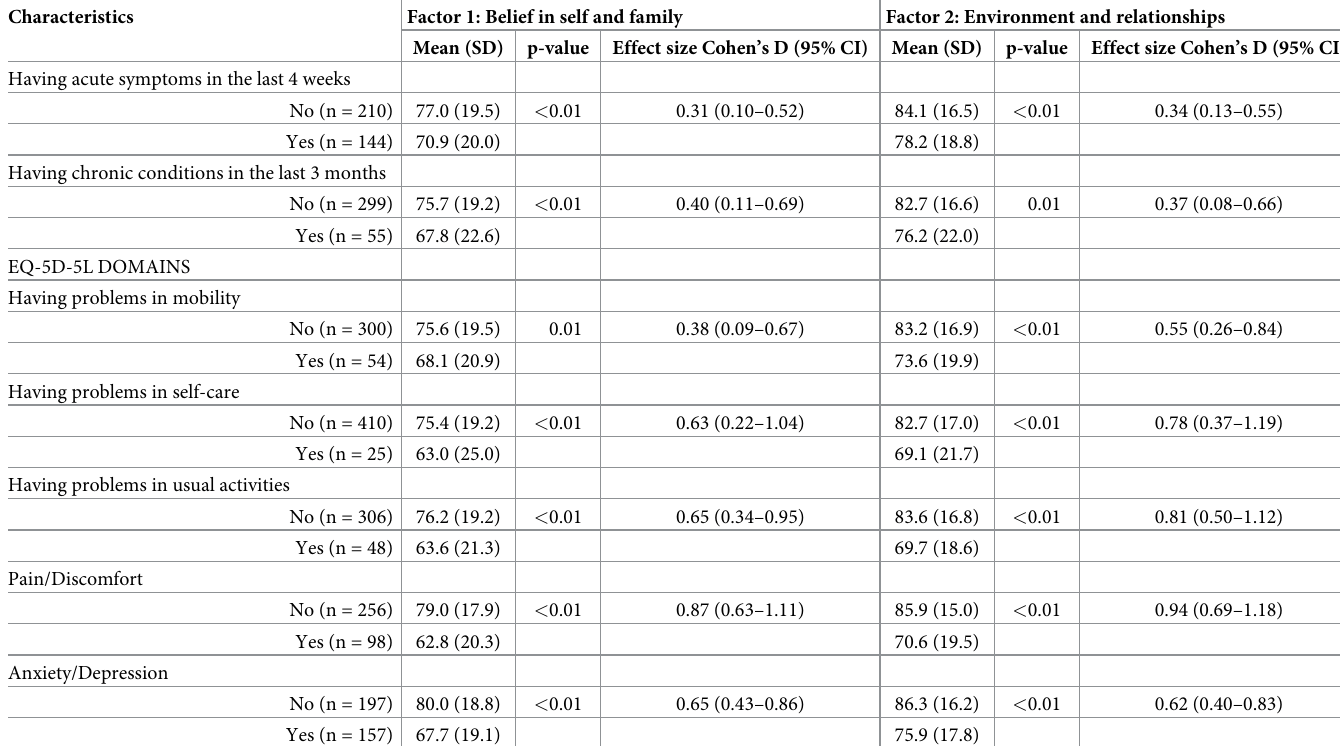
Table 6. Known-group validity. Characteristics Factor 1: Belief in self and family Factor 2: Environment and